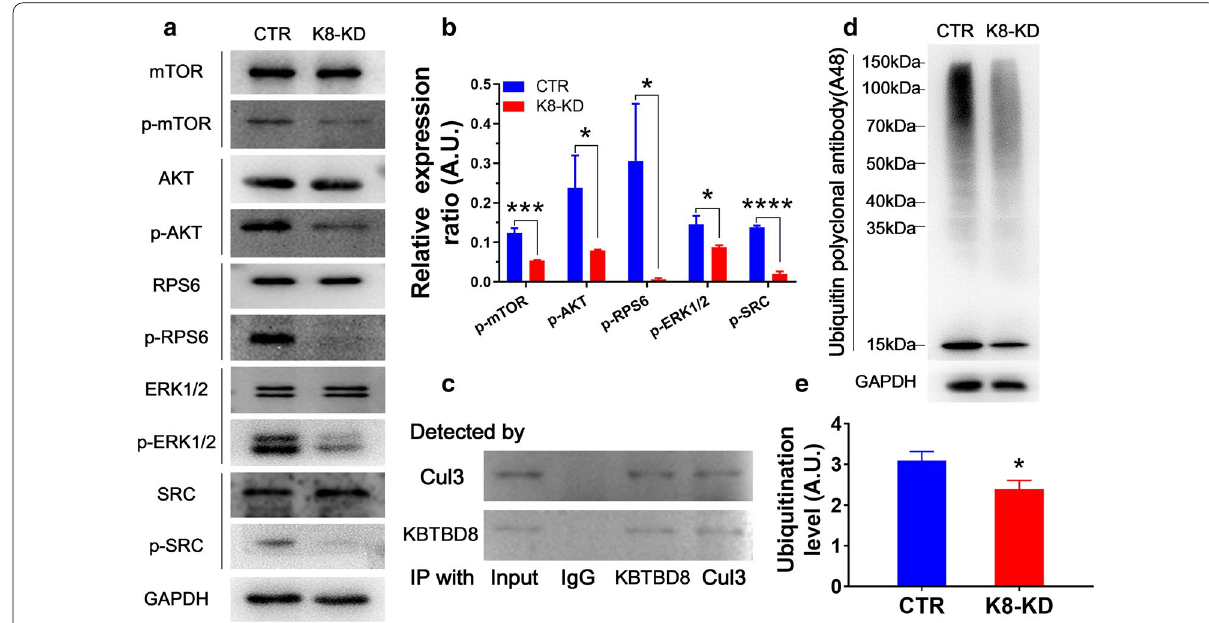
Fig. 6 Human KBTBD8 regulated the activity of multiple cell cycle kinases in EOC cells. a , b Blot and quantification showed that KBTBD8 knockdown decreased the level of p‑MTOR, p‑Akt, p‑Rps6, p‑Erk1/2 and p‑Src in A2780 cells (CTR vs. K8‑KD, p‑MTOR level, 0.1240 vs. 0.05371; p‑Akt level, 0.2387 vs. 0.07942; p‑Rps6 level, 0.3059 vs. 0.006376; p‑Erk1/2 level, 0.1456 vs. 0.08771; p‑Src level, 0.1378 vs. 0.02054), while KBTBD8 knockdown did not decreased the level of total MTOR, Akt, Rps6, Erk1/2, and Src level in A2780 cells. c Co‑IP and blot showed that cul3 and KBTBD8 interacted with each other. d , e Blot and quantification showed that KBTBD8 knockdown significantly diminished the overall level of ubiquitination (ubiquitination level, CTR vs. K8‑KD, 3.085 vs. 2.391). A.U., arbitrary unit. *Indicates p < 0.05, ***indicates p < 0.001, ****indicates p <